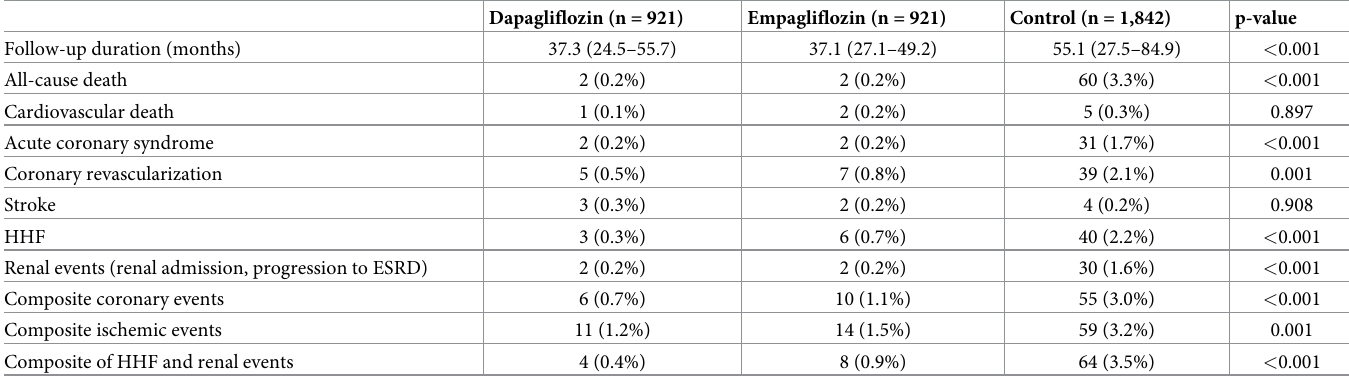
Table 2. Clinical outcomes.